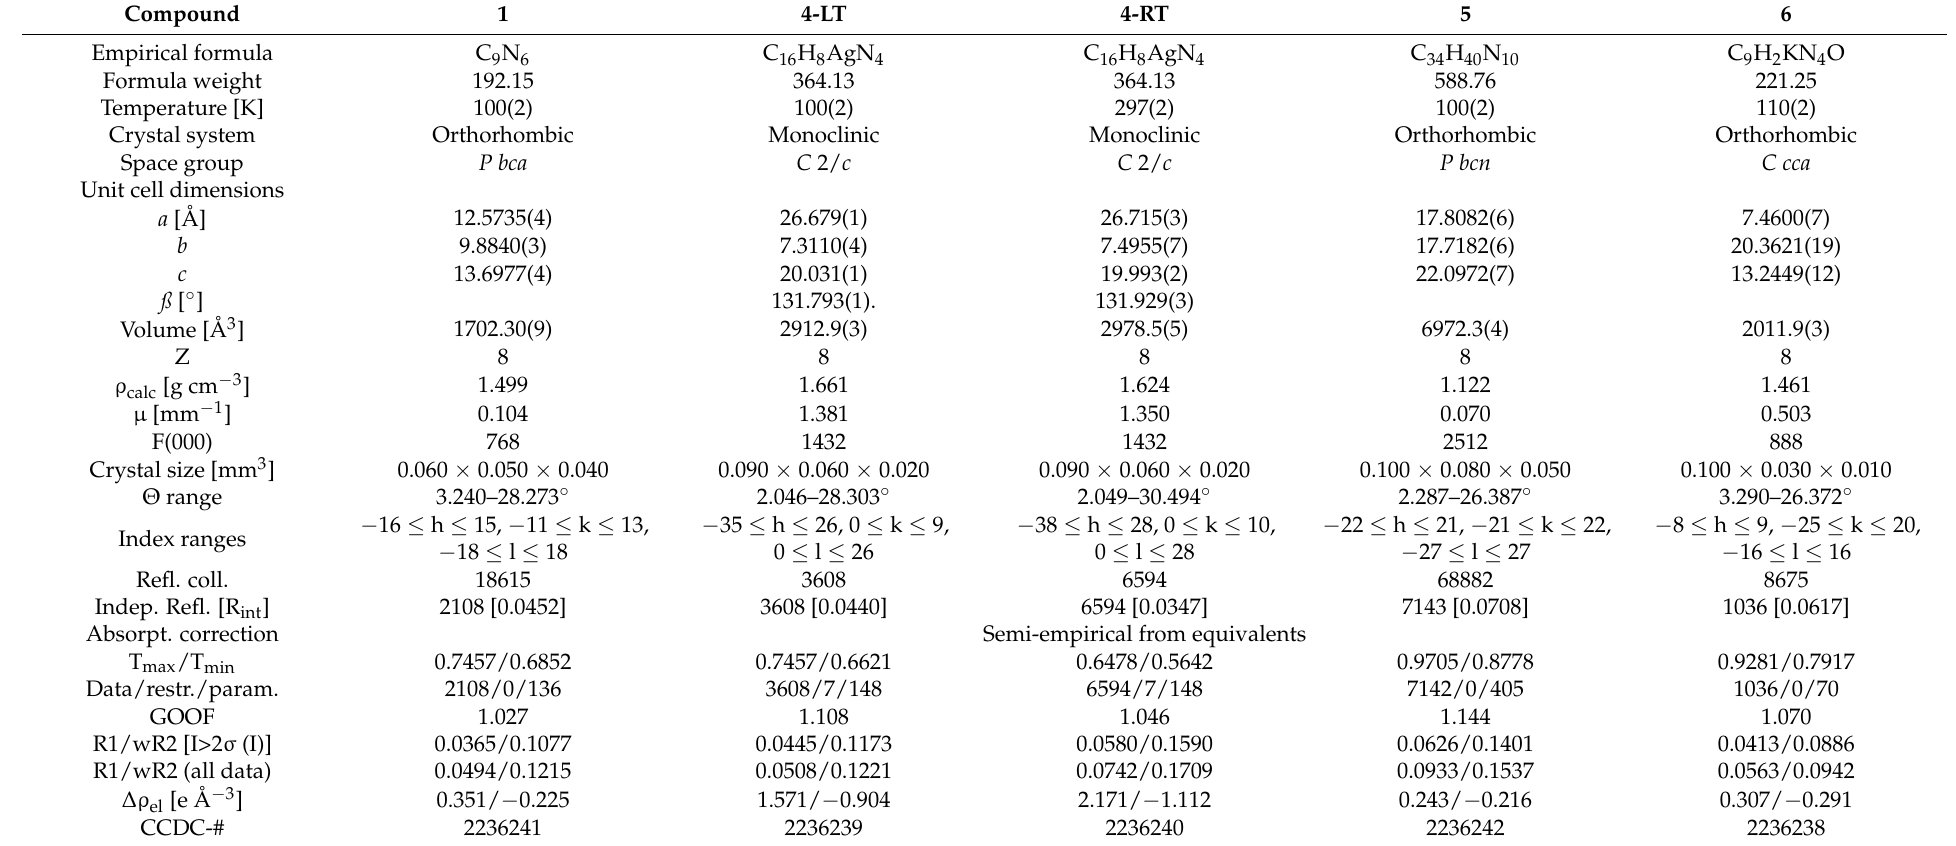
Table 5. Experimental details of the crystal structure